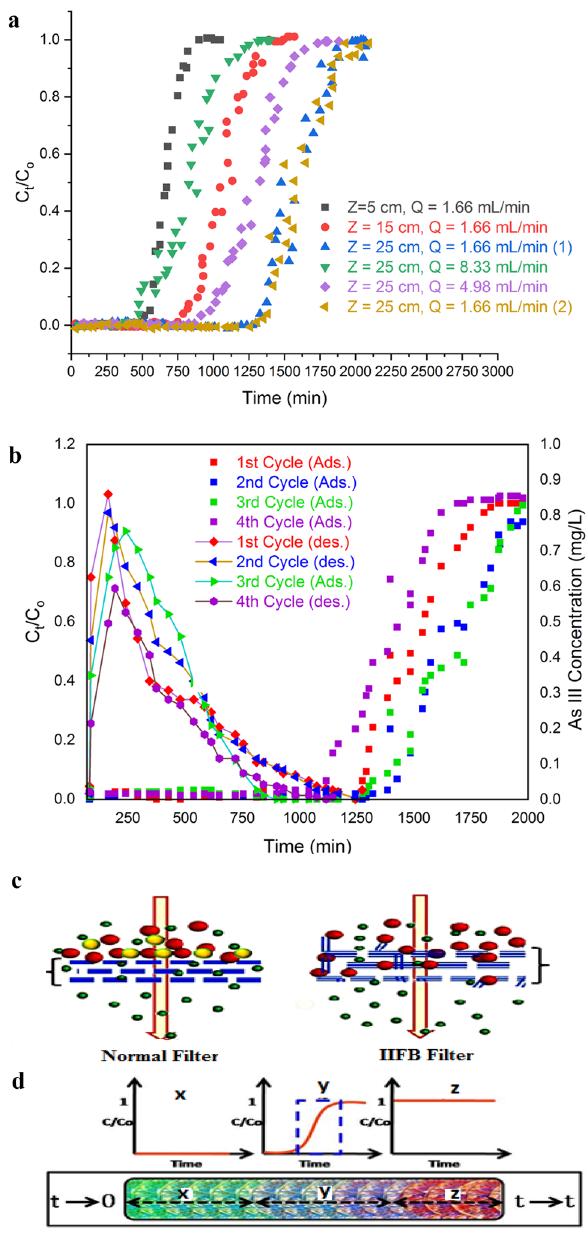
Figure 7. ( a ) Breakthrough curves for As(III) removal in continuous up-flow packed-bed bioreactor at different bed heights (5, 15, 25 cm) of IIFB biosorbent and different flow rates (1.66, 4.98 and 8.33 mL min −1 ) at pH 7 and As(III) inlet concentration of 1.1 mg/L. ( b ) Adsorption and desorption curves for As(III) removal in IIFB packed-bed-bioreactor in successive four cycles. ( c ) Sorption based filtration action of IIFB discs. ( d ) Filter exhaustion profile with respect to time (0 to t) and corresponding sections (x, y and z) of breakthrough